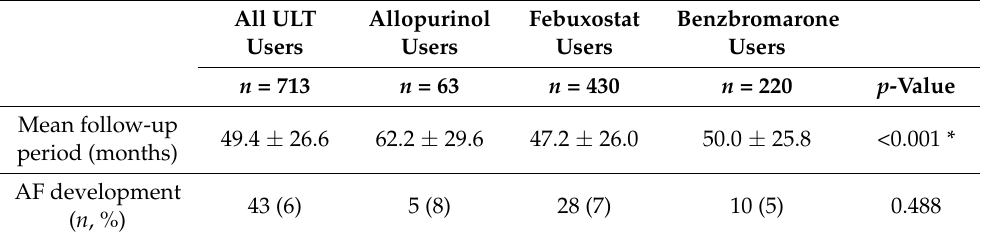
Table 2. Crude incidence of AF development among patients receiving different urate-lowering drugs.